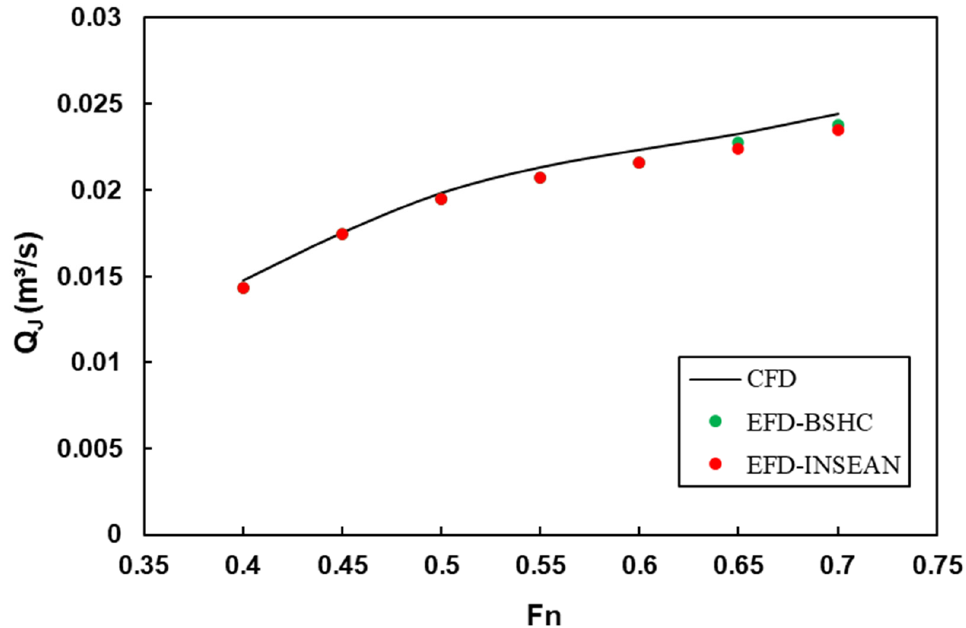
Figure 24. The comparison of volume flow between CFD results and EFD data for self-propulsion